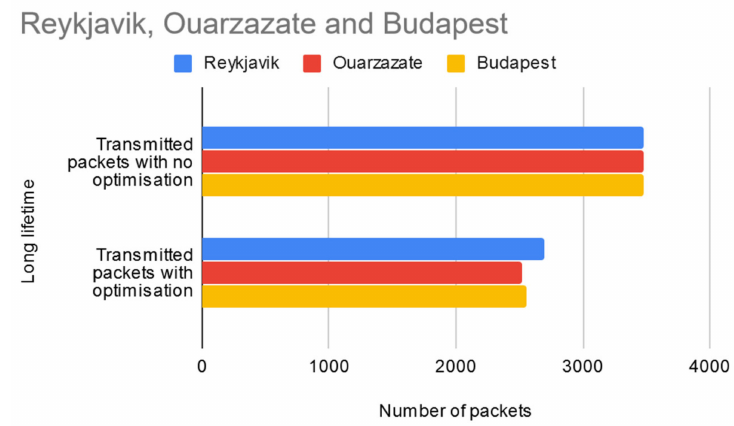
Figure 8. Test results for long network lifetime scenario.